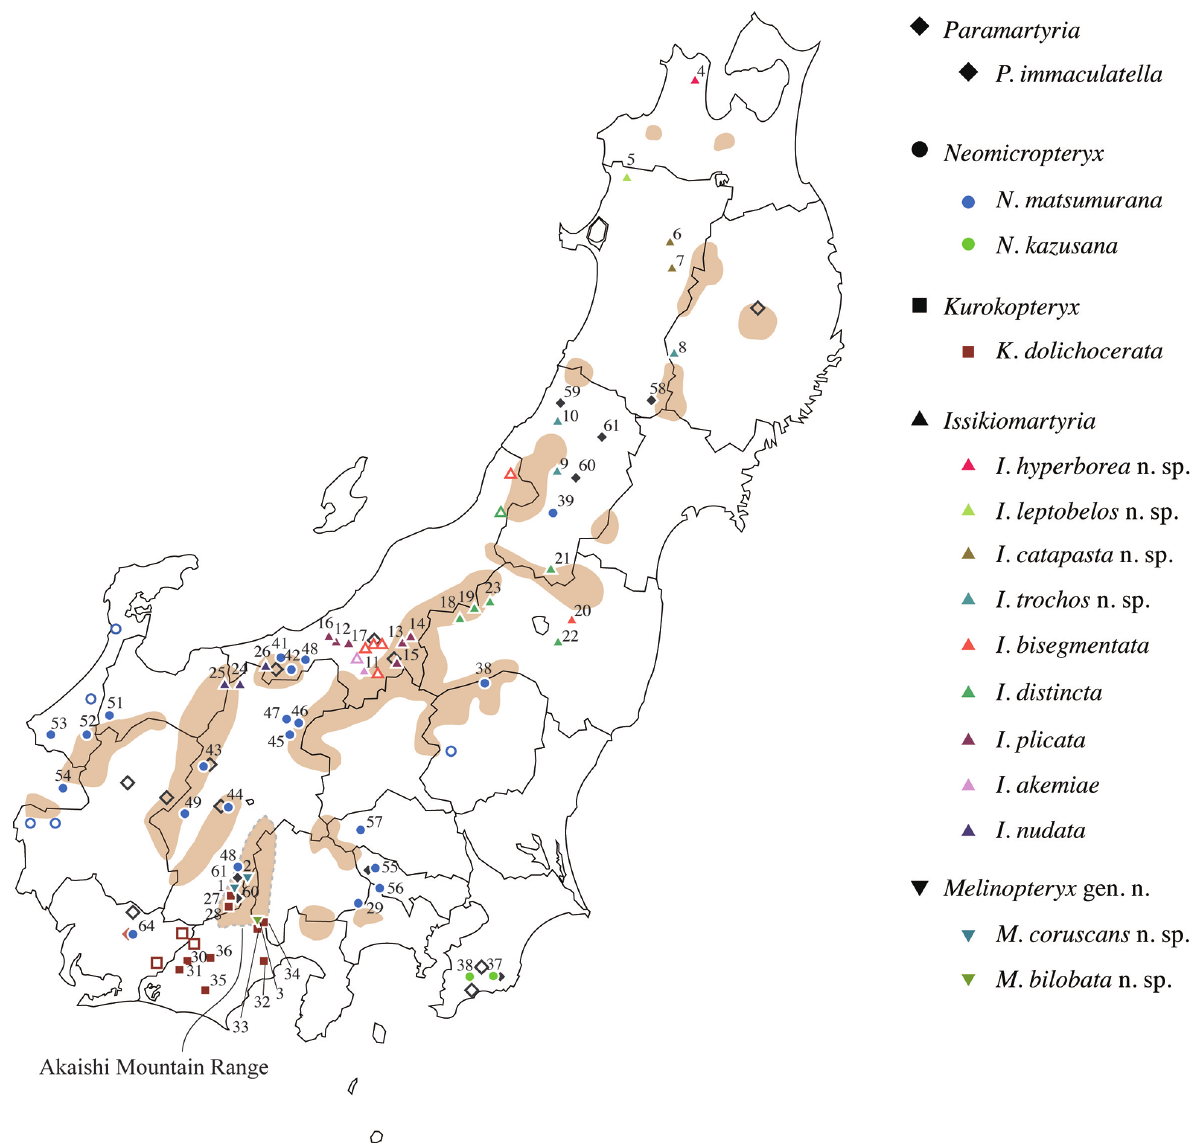
Figure 19. Locality records of micropterigid moths in the Northeastern Japan. Locality codes correspond to those in the text. Shaded are the areas higher than 1000 m elevation. Sampling records from Hashimoto (2006) are indicated as outlined